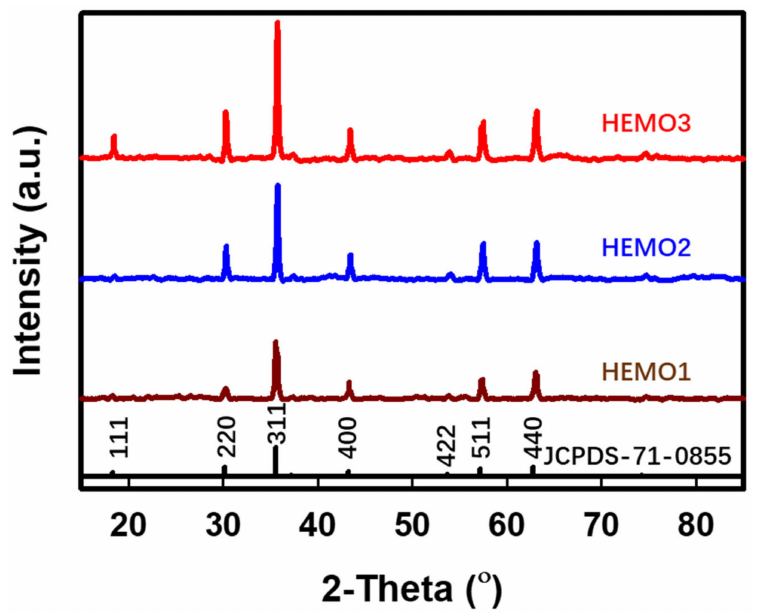
Figure 2. XRD spectra for the HEMO samples. XRD patterns for the fabricated HEMO1, HEMO2, and HEMO3